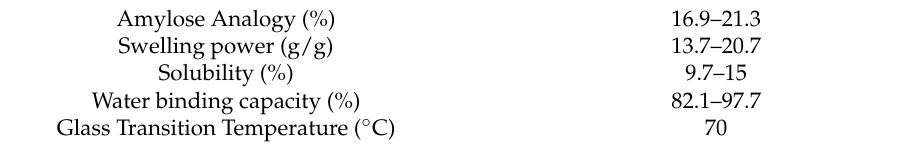
Table 1. Physical properties of corn starch.